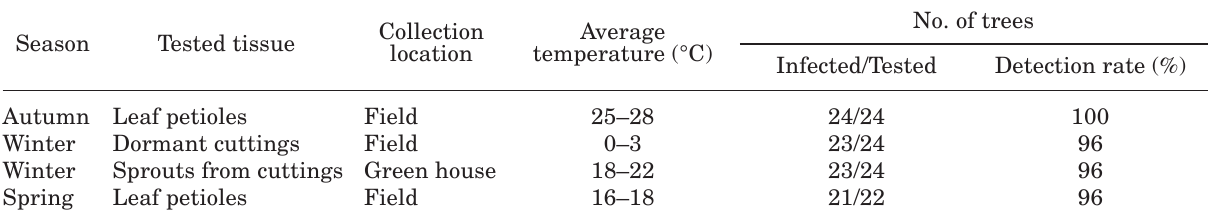
Table 3. PLMVd tracking in